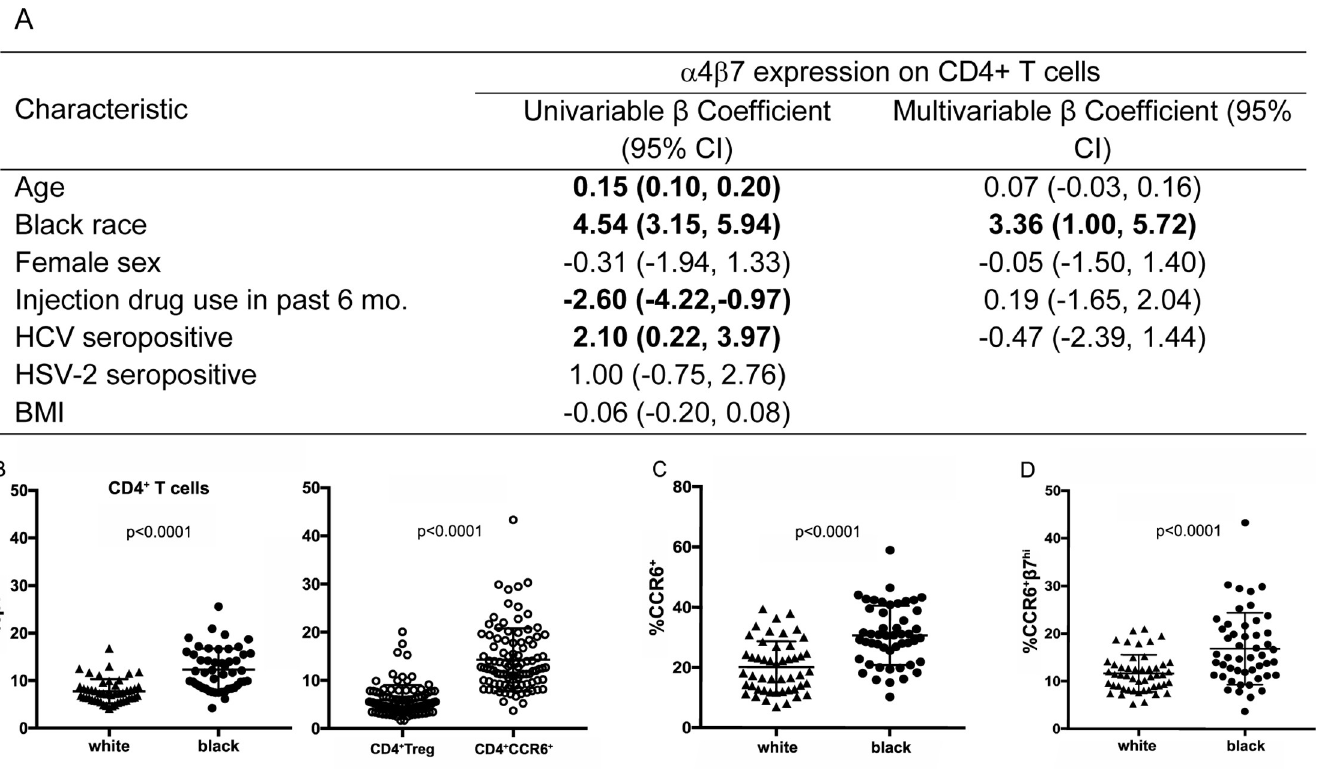
Fig 1. Measurement of α 4 β 7 expression on total CD4 + T cells and subsets, and differences by race. A) Correlates of α 4 β 7 expression on CD4+ T cells examined using linear regression. Multivariable analysis included age, black race, sex, injection drug use status, and HCV status. Only race varied in β 7 expression in multivariable analysis. B) β 7 hi expression on CD4 + T cells by race and T cell subset. White participants had significantly lower proportions of β 7 hi CD4 + T cells than black participants. CD4 + CCR6 + cells had higher % β 7 hi than Tregs. C) Differences in proportion of CD4 + CCR6 + cells by race. Black individuals had overall higher proportions of CD4 + CCR6 + cells than white participants. D) Racial differences in % CD4 + β 7 hi CCR6 + cells by race. Crossbars represent the mean and standard deviation.